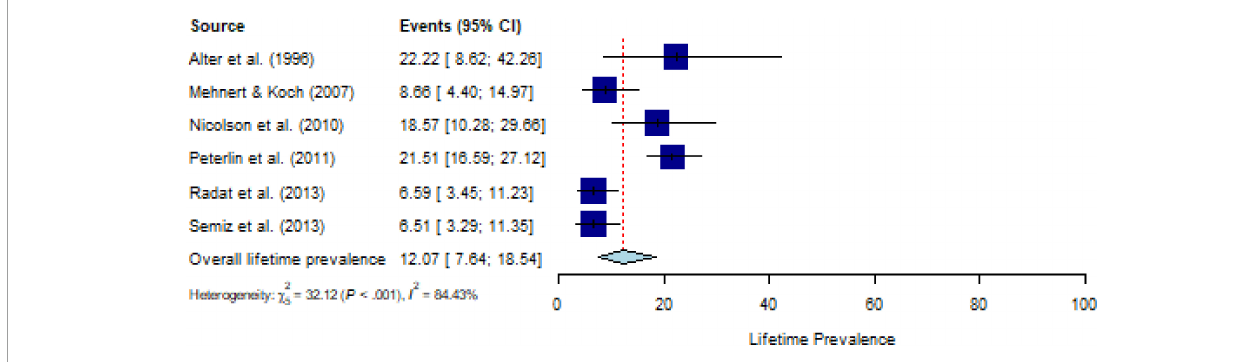
FIGURE5 Forest plot of lifetime prevalence of post-traumatic stress disorder (PTSD) in people with chronic somatic diseases (CD).